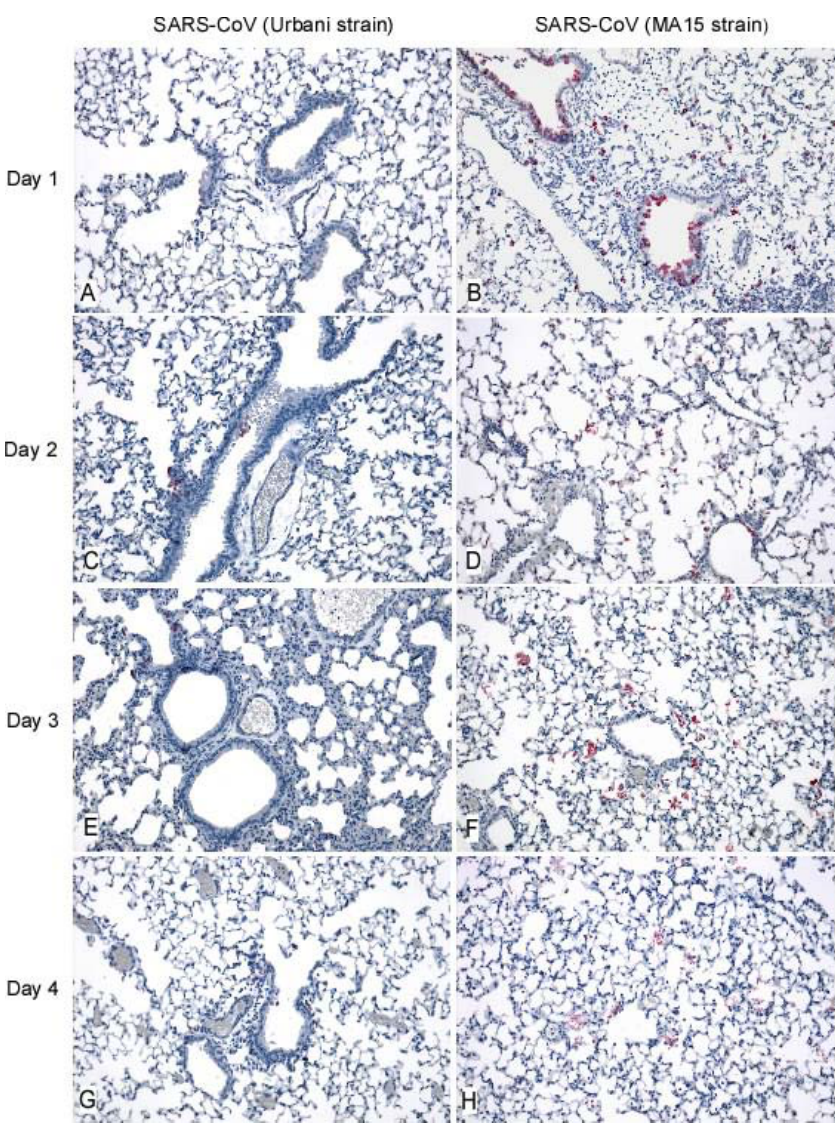
Immunohistochemical staining is shown in red. Day 1 p.i. (A) SARS-CoV (Urbani)–infected mice: antigen present in occasional ciliated respiratory epithelial cells in bronchioles. (B) MA15-infected mice: diffuse and extensive staining of bronchiolar respiratory epithelium and alveolar pneumocytes. Day 2 p.i. (C) SARS-CoV (Urbani)–infected mice: staining of occasional bronchiolar epithelial cells and rare alveolar pneumocytes. (D) MA15-infected mice: staining predominantly in intact and detached cells in pulmonary alveoli. Day 3 p.i. (E) SARS-CoV (Urbani)–infected mice: occasional staining of alveolar pneumocytes and bronchiolar epithelium. (F) MA15-infected